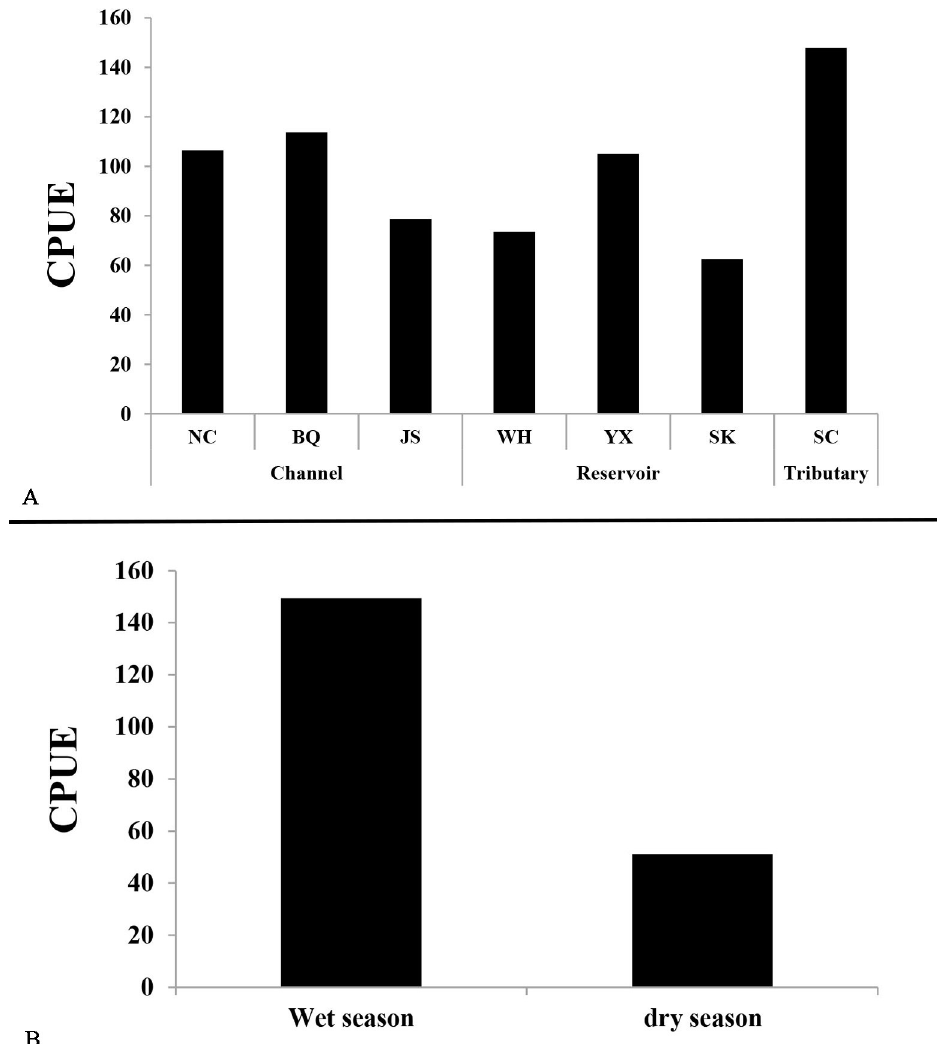
Fig 2. Comparison of CPUE for fish composition across sections (A) and sampling periods (B) in the middle and lower reaches of the Ganjiang River.